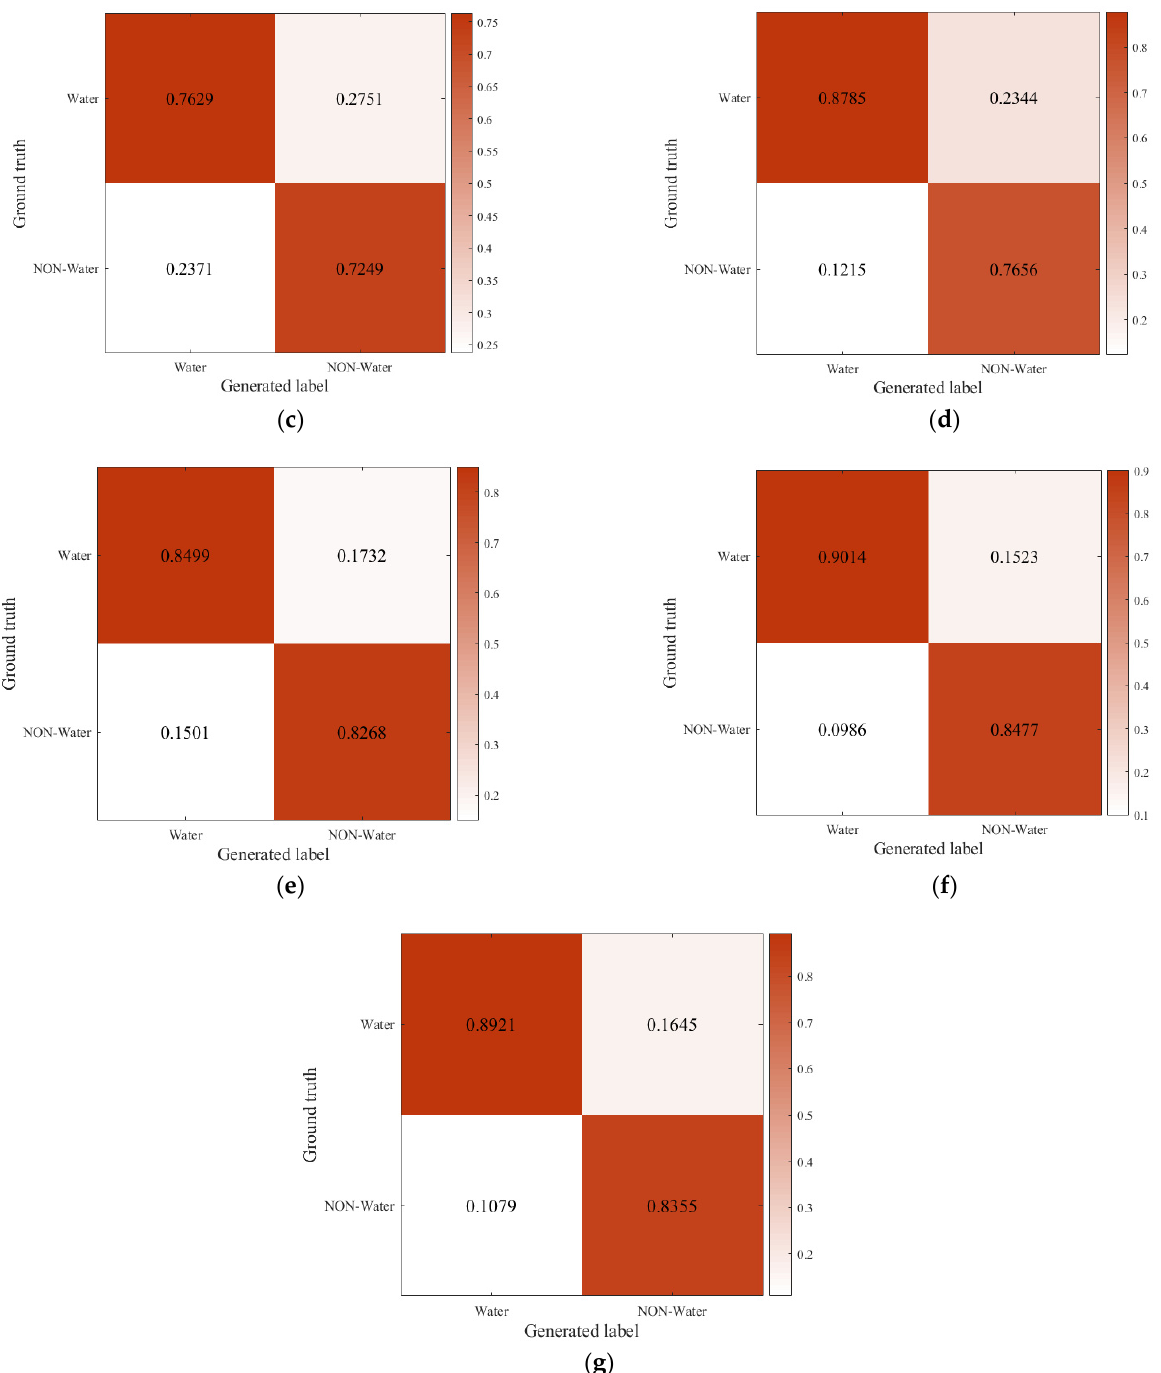
Figure 14. Confusion matrices for different methods. ( a ) FFEDN. ( b ) RF. ( c ) SVM. ( d ) U-Net. ( e ) U-Net-ResNet. ( f ) MSF-MLSAN. ( g ) WENET. Table 13. Quantitative evaluation of different models. Among them, the proposed FFEDN achieved the best accuracy. Precision scored 95.21%, recall scored 91.79%, IoU scored 87.73%, OA scored 93.35%, and AA scored